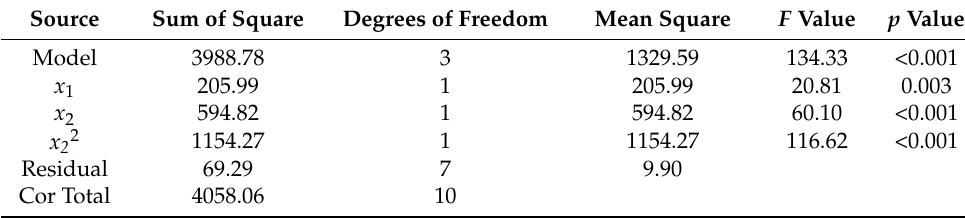
Table 5. Result of ANOVA for cutting force F